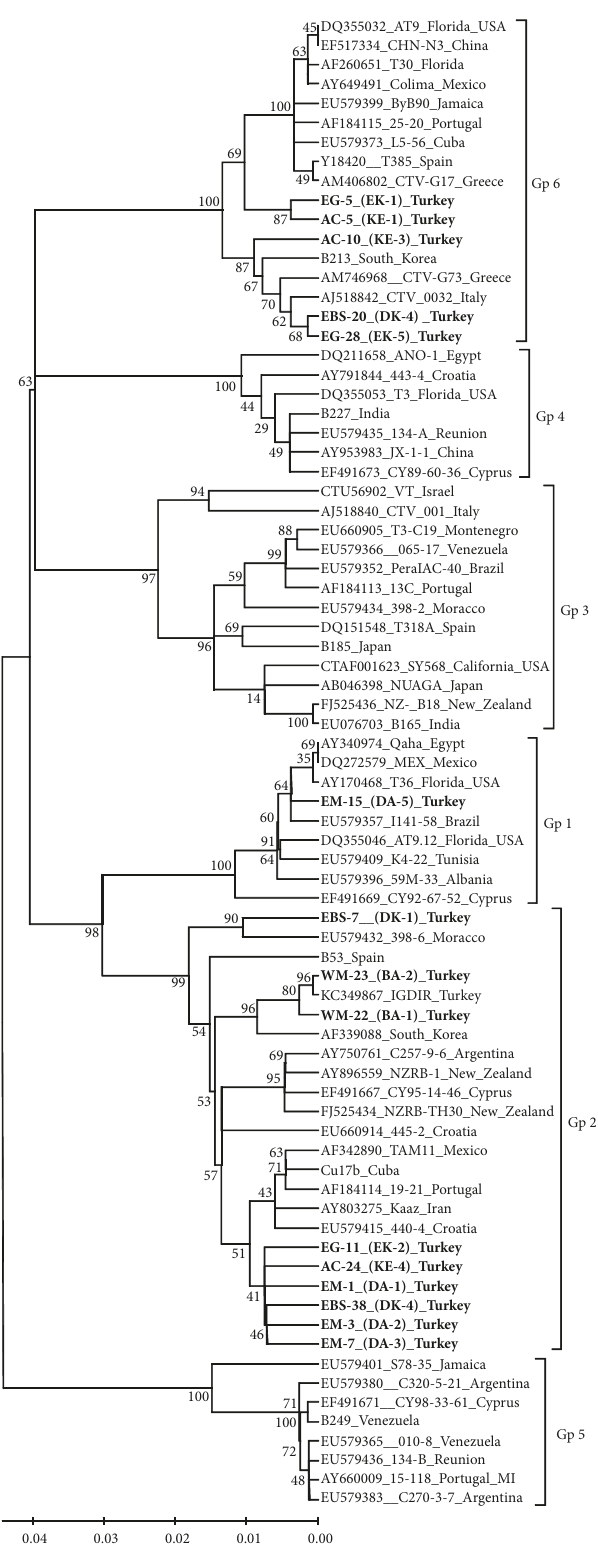
Figure 3: The phylogenetic tree showing genetic relationship between Turkish isolates and isolates from different citrus growing regions of the world including the type isolates of previously established strain specific groups [13, 14]. The phylogenetic tree was constructed with nt sequences of the CP gene of isolates using neighbor joining algorithm in MEGA 6 [35] tested by a bootstrap analysis with 100 replications. The bootstraps values are shown on branches of the phylogenetic